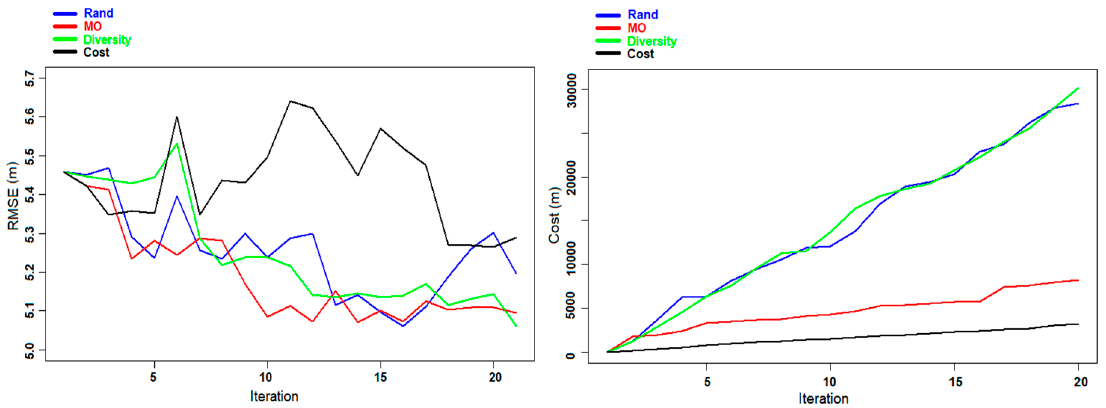
Figure 5. Experiment A: Evolution of the RMSE ( left panel ) and the cost ( right panel ) for DBH prediction for the Våler dataset during the different iterations.